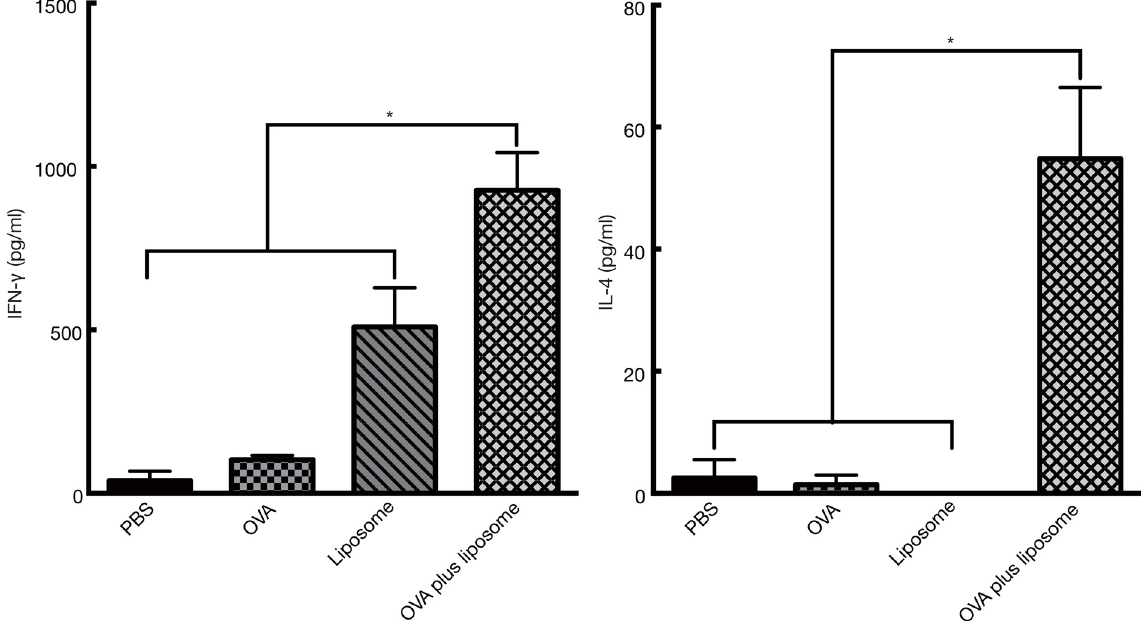
Fig 8. In vitro antigen-specific production of IFN- γ and IL – 4 in splenocytes and nasal passages from BALB/c mice immunized intranasally with OVA and DOTAP/DC-chol liposomes. Splenocytes from vaccinated BALB/c mice were cultured for 72 h in the presence of OVA (0, 1, 10, or 100 μ g/ml). After culture, the supernatants were collected, and concentrations of IFN- γ and IL – 4 in the culture supernatants were determined by ELISA assay. The data are representative of at least three independent experiments and are expressed as the mean ± standard deviation for samples assayed in triplicate. Significance was assessed with the t -test with Welch correction: * p < 0.05.